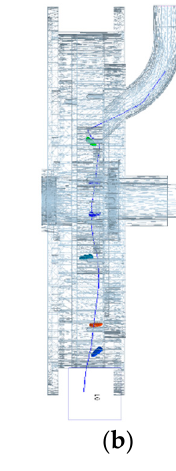
Figure 12. Seed trajectory diagram. ( a ) Main view; ( b ) Left view.